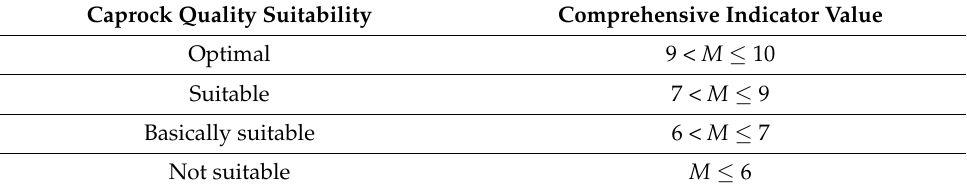
Table 8. Evaluation table of comprehensive suitability grade of gas storage caprock of depleted oil and gas reservoir. Caprock Quality Suitability Comprehensive Indicator Value Optimal